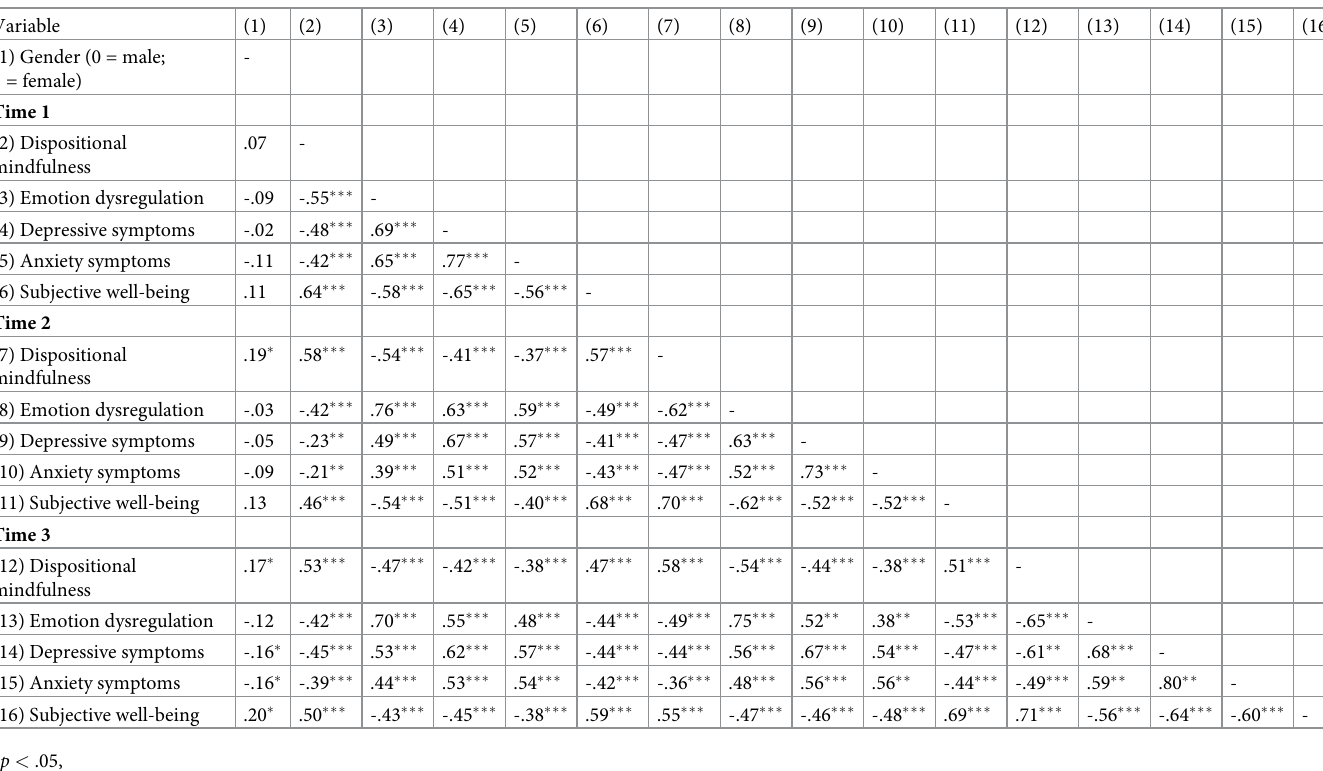
Table 2. Zero-order correlations of the variables under study ( N =